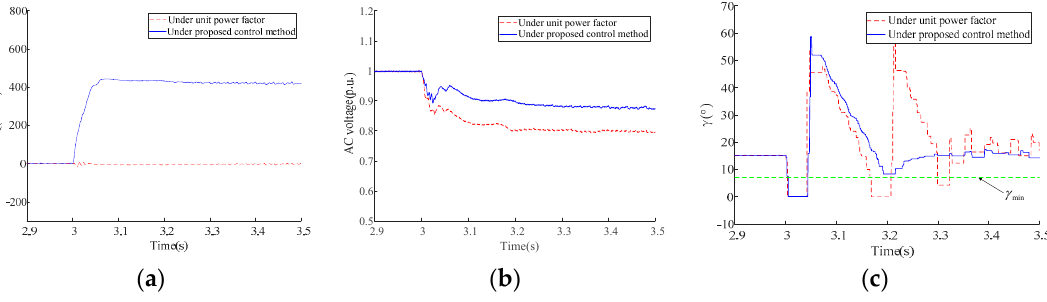
Figure 7. System performance under different control strategies. ( a ) Reactive power of the VSC-HVDC inverter; ( b ) Commutated bus voltage at the inverter side of the LCC-HVDC; ( c ) Extinction angle of the LCC-HVDC inverter.